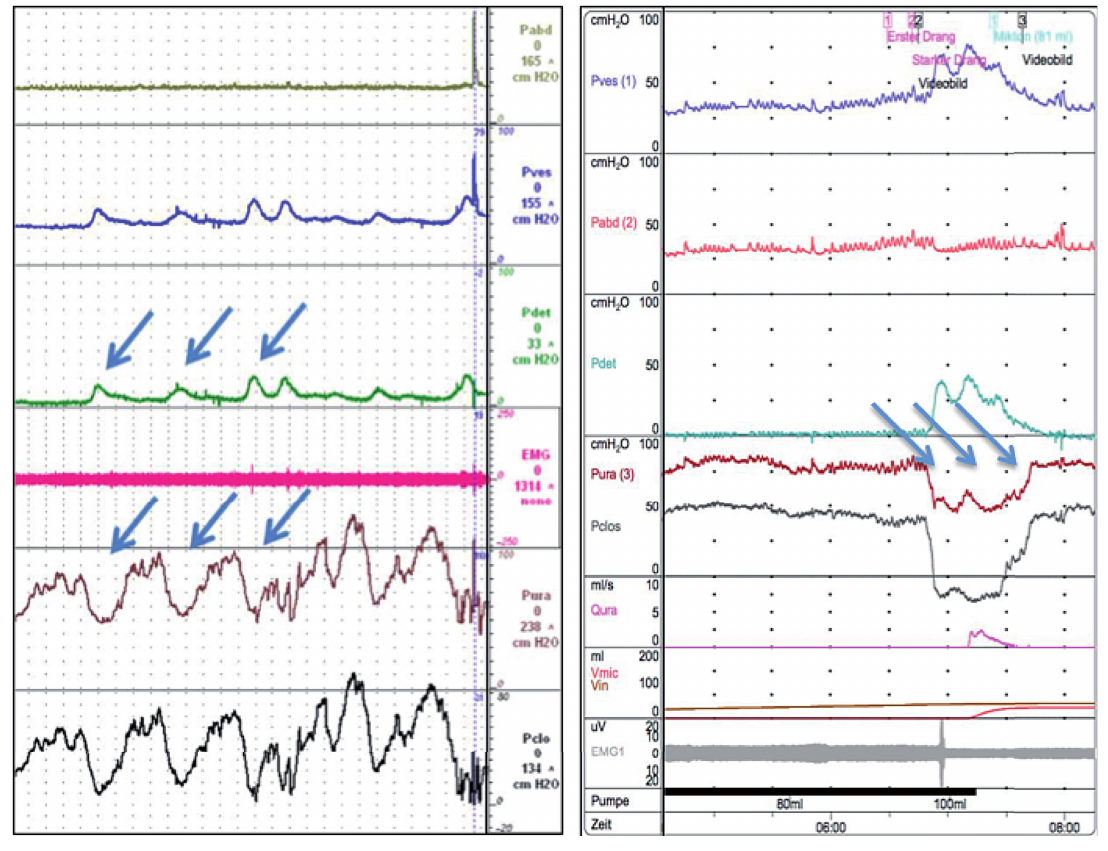
Figure 1 - Urodynamic evaluation in a patient with DO (left) and SUI (right).